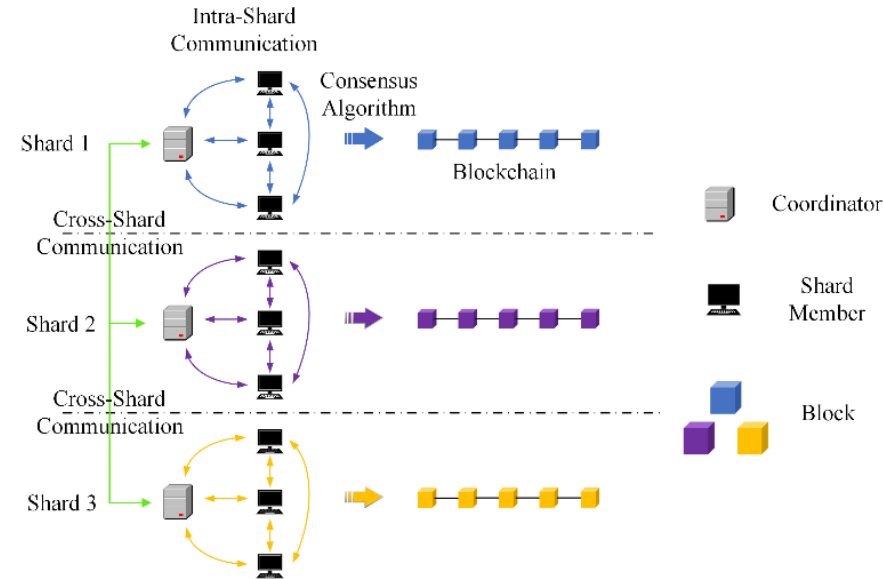
Figure 2. Communications in sharding blockchain systems.